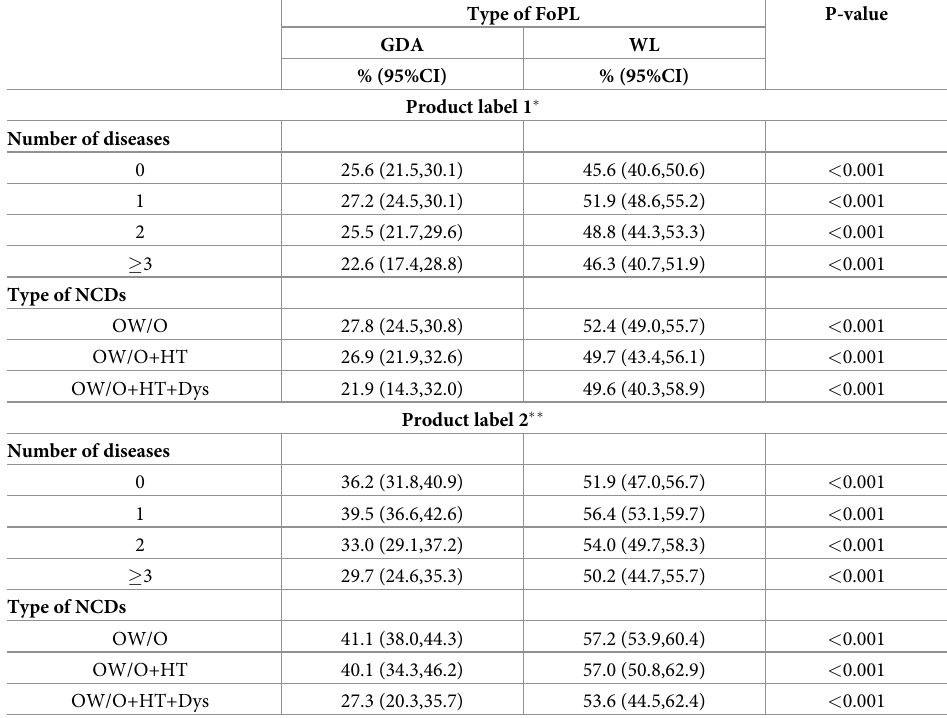
Table 3. Proportions of correct classification of two product labels according to the number of diseases and type of non-communicable diseases.